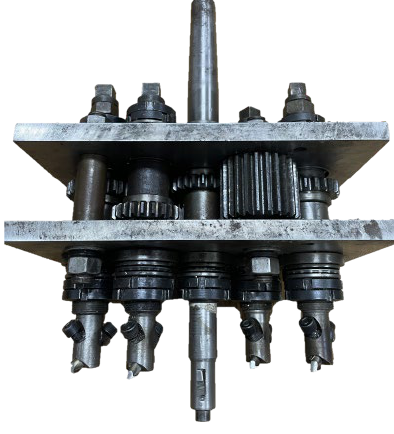
Figure 7. Processing tool drawings.